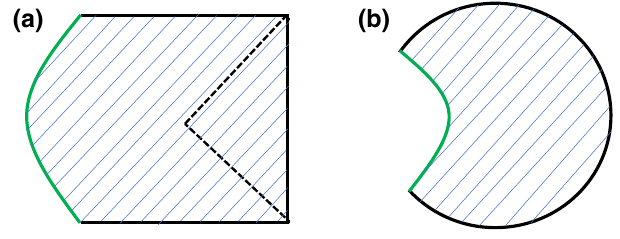
FIG. 9. Lorentzian and Euclidean geometries for a black hole with an end-of-the-world brane (denoted by the green line).